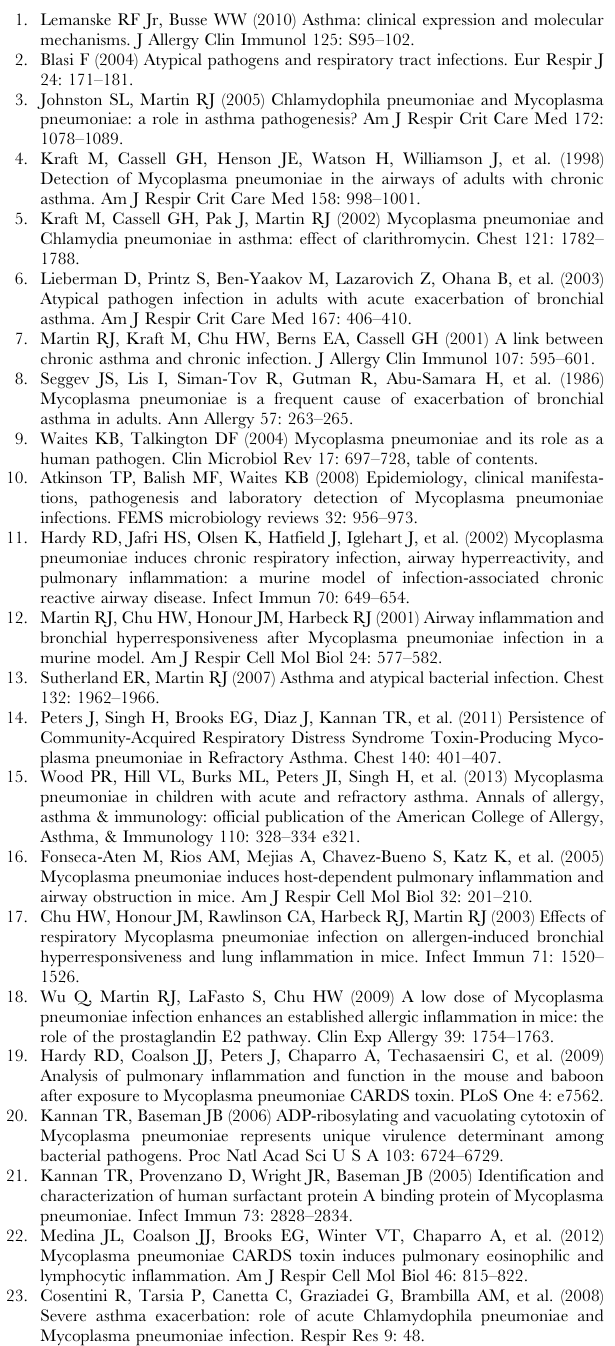
Figure S2 Representative H&E image from a lung section of a mock treated animal